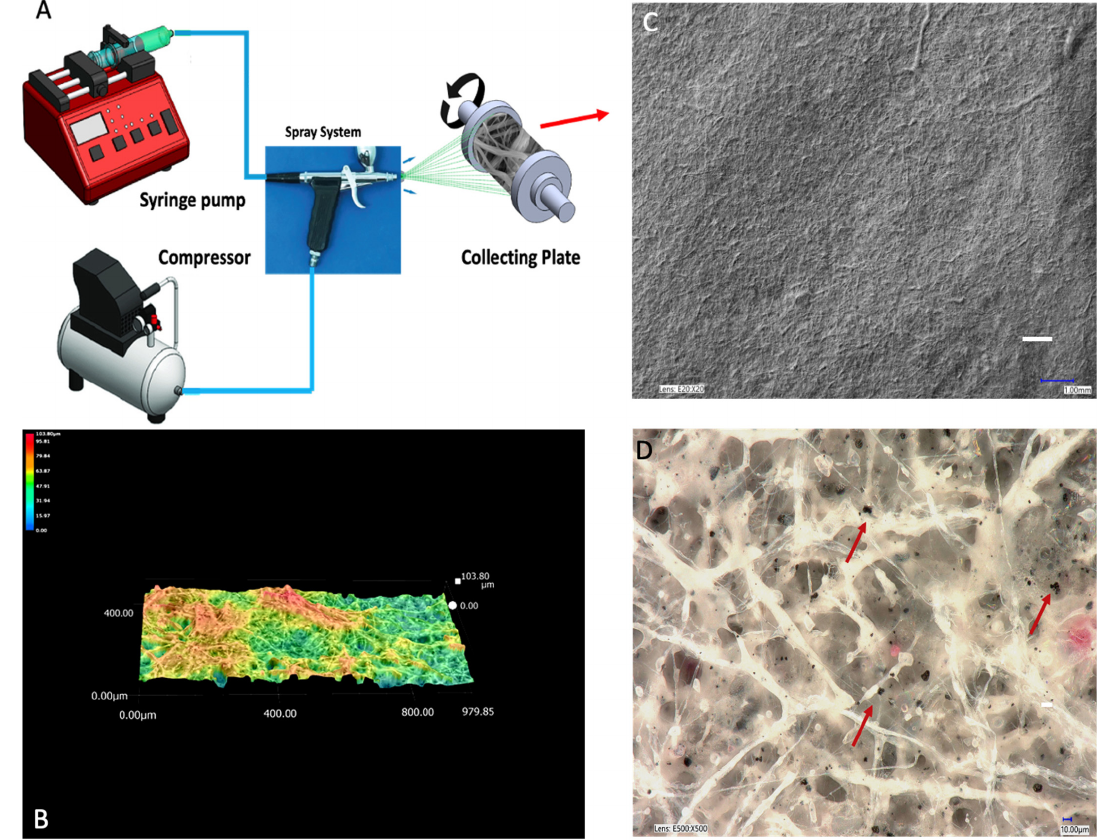
Figure 1. ( A ) Typical blow spinning set-up. ( B ) Surface topography map of a blow-spun textile composed of PCL and zinc-coated halloysite nanotubes (ZnHNTs). ( C ) Digital micrograph of the surface of a PCL/ZnHNT blown spun fabric. White bar equals 1 mm. ( D ) High power view of PCL fibers with embedded zinc-coated halloysite nanotubes (back specs) indicated by red arrows). White bar equals 1 µm. All figures are obtained from the corresponding author’s collection.